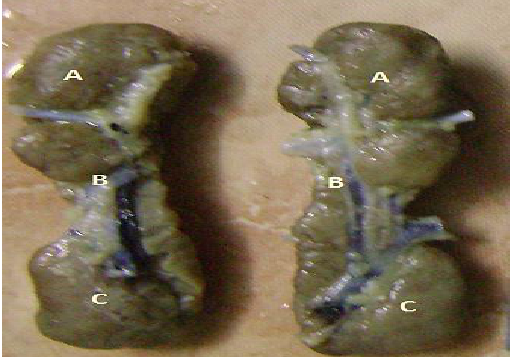
Figure, 3: Anatomical specimen of Mallard duck shows (A) kidneys cranial lobe, (B) Kidneys middle lobe, (C) Kidneys caudal lobe, (D) Lung